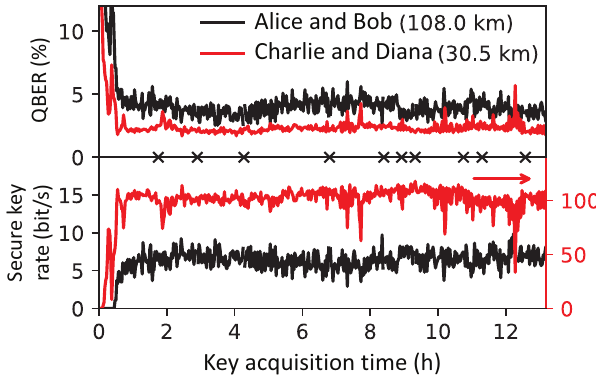
FIG. 9. The QBER and secure key rate acquired during the field test. A wavelength-selective switch is employed for demul- tiplexing of the SPDC spectrum. Alice is connected via the deployed fiber (26.8 km; see Fig. 8). The other participants are connected via spooled fiber: Bob via 81.2 km, Charlie via 9.6 km, and Diana via 20.9 km. The total distance between two users is the sum of the individual link lengths. Diana’s time tagger is syn- chronized to the photon source, while for the other participants synchronization is achieved via clock recovery from the pho- ton arrival times. Black crosses indicate runs where Bob’s clock recovery fails and the delay to Alice is therefore automatically recalibrated via